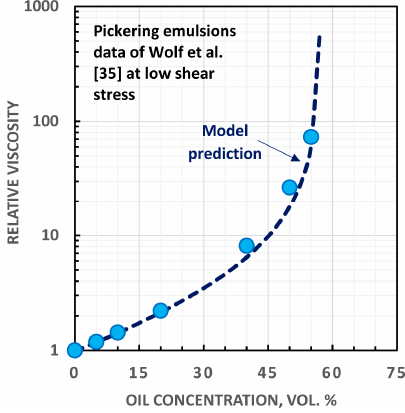
Figure 11. Comparison of the literature relative viscosity data for Pickering O/W emulsions with the predictions of the proposed model.